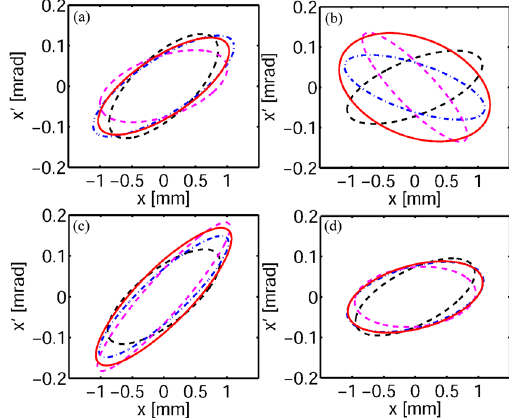
FIG. 5. Slice and projected phase space ellipses in four situations respectively: (a) with two CS widely open; (b) with downstream CS gap set at 3.2 mm; (c) with upstream CS gap set at 3.2 mm; (d) with both CS gaps set at 3.2 mm. The phase spaces for the head slice, central slice and tail slice are shown with dashed black line, dotted dashed blue line and dashed magenta line, respectively. The projected phase space is shown with solid red